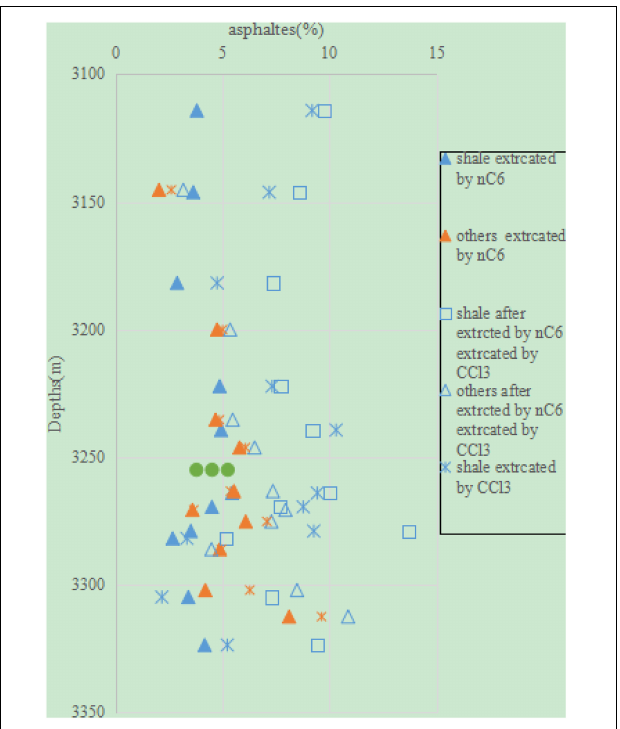
studies (Chishti and Williams, 1999; Jefimova et al., 2014;